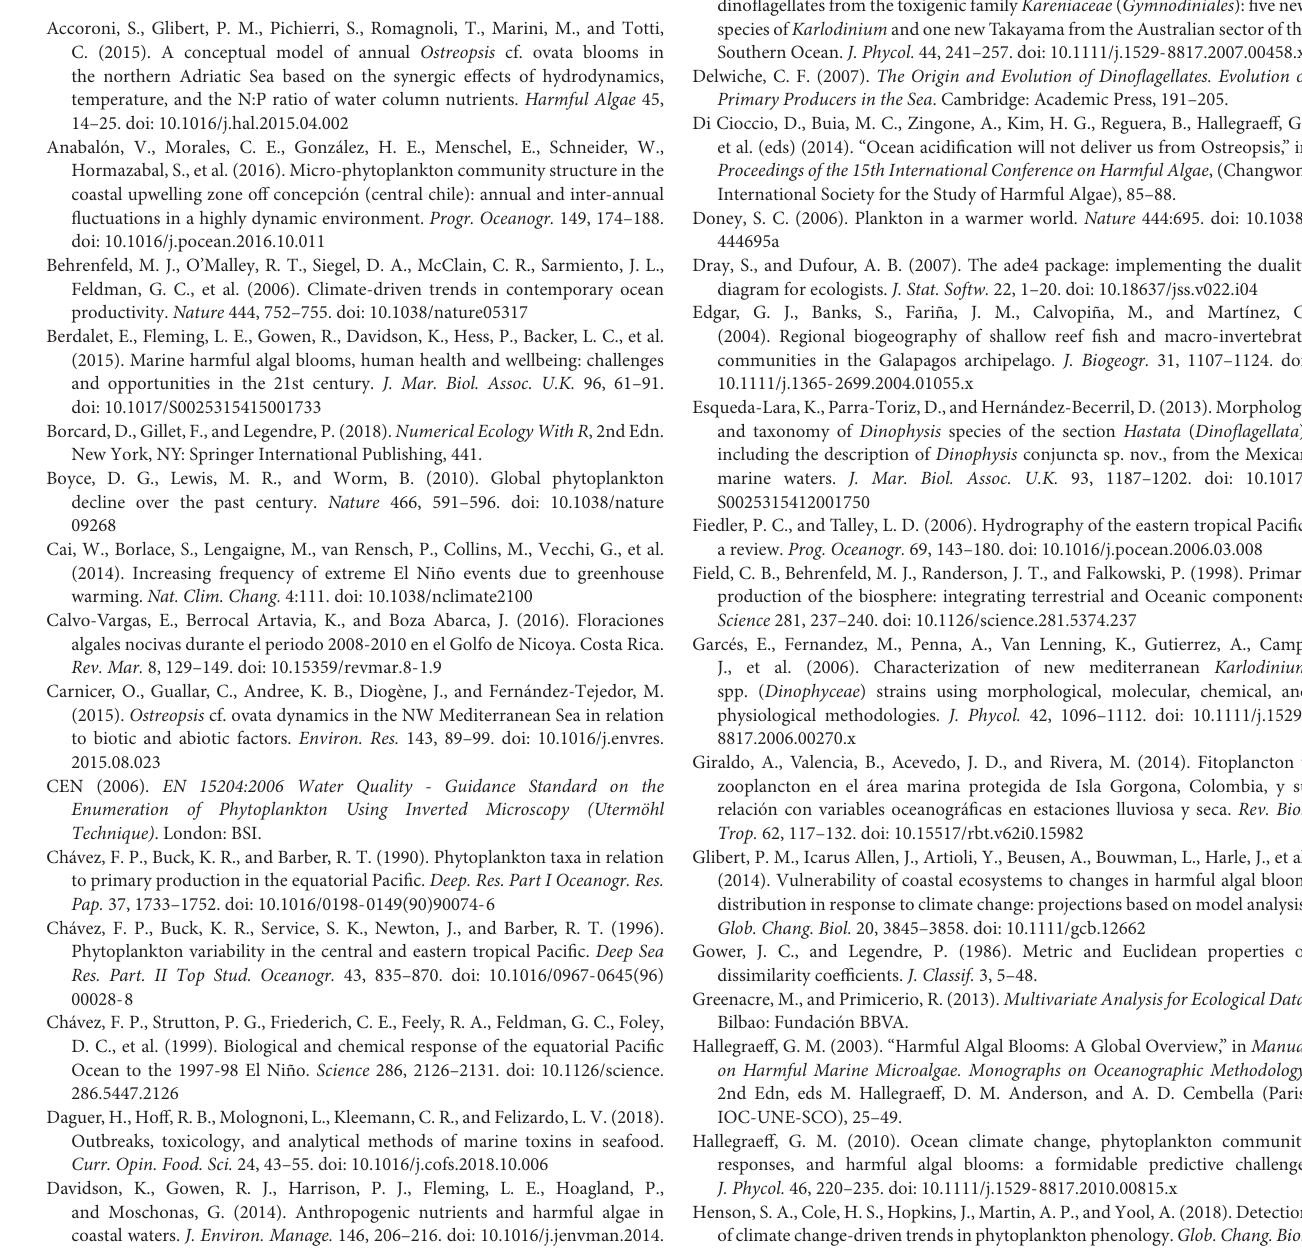
FIGURE S4 | Vertical profiles for dissolved oxygen (mg L − 1 ). The information for each island and transect is showed in columns and rows, respectively. Station is color code: blue color for 2 nm, green color for 5 nm and yellow color for 10 nm. FIGURE S5 | Vertical profiles for pH. The information for each island and transect is showed in columns and rows, respectively. Station is color code: blue color for 2 nm, green color for 5 nm, and yellow color for 10 nm. TABLE S1 | Presence of dinoflagellate species in net samples. TABLE S2 | Cell abundance estimation from Van Dorn bottle